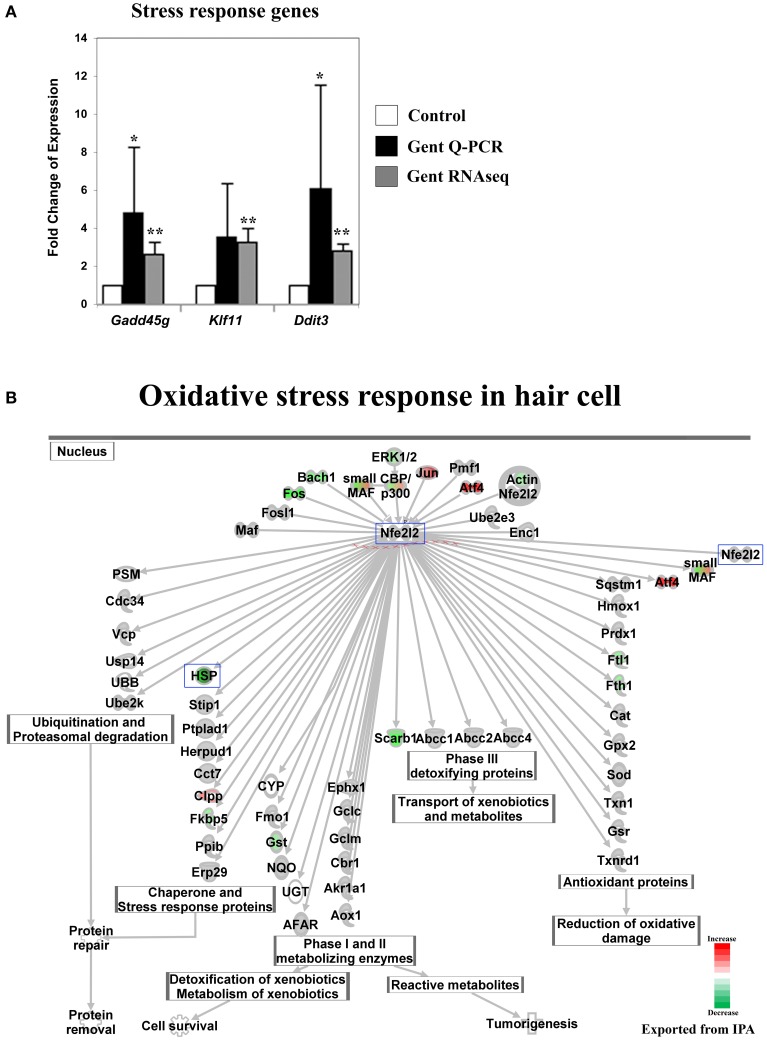
Gentamicin-induced changes in expression of stress-response genes. (A) Q-PCR results validating increased messenger RNA levels in hair cells after gentamicin treatment. Error bar, standard deviation: *p < 0.1; **p < 0.01. (B) NRF2-mediated oxidative stress response network with color-coded expression shifts showing the absence of significant induction of oxidative stress response at the transcriptional level. Only genes with significant expression changes are color labeled. Red, increased expression; green, decreased expression relative to control; half red-half green, indicates nodes with multiple genes with some genes upregulated and some genes downregulated. Genes validated and discussed in the text are boxed in the corresponding protein pathway diagrams.